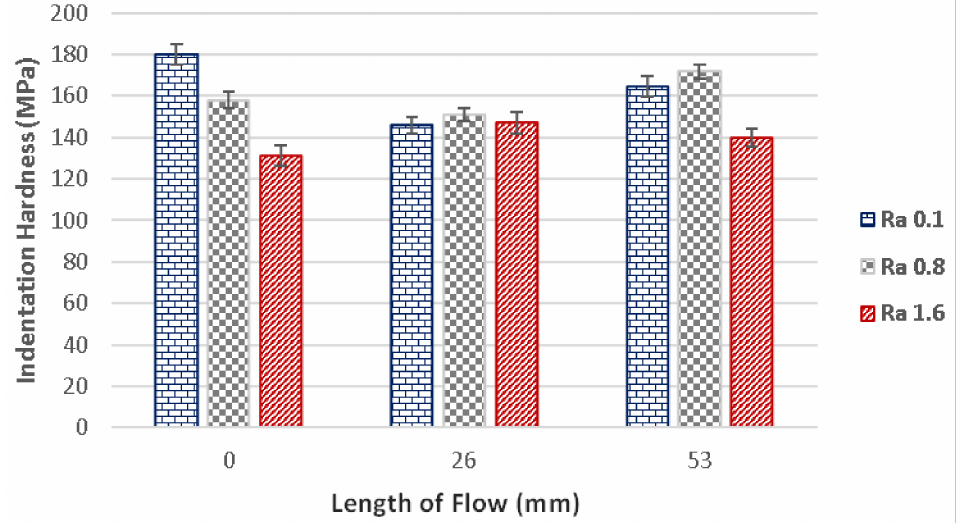
Figure 7. The dependence of flow length on the indentation hardness for following surface qualities: Ra 0.1, Ra 0.8, Ra 1.6 and injection pressure 400 bar.